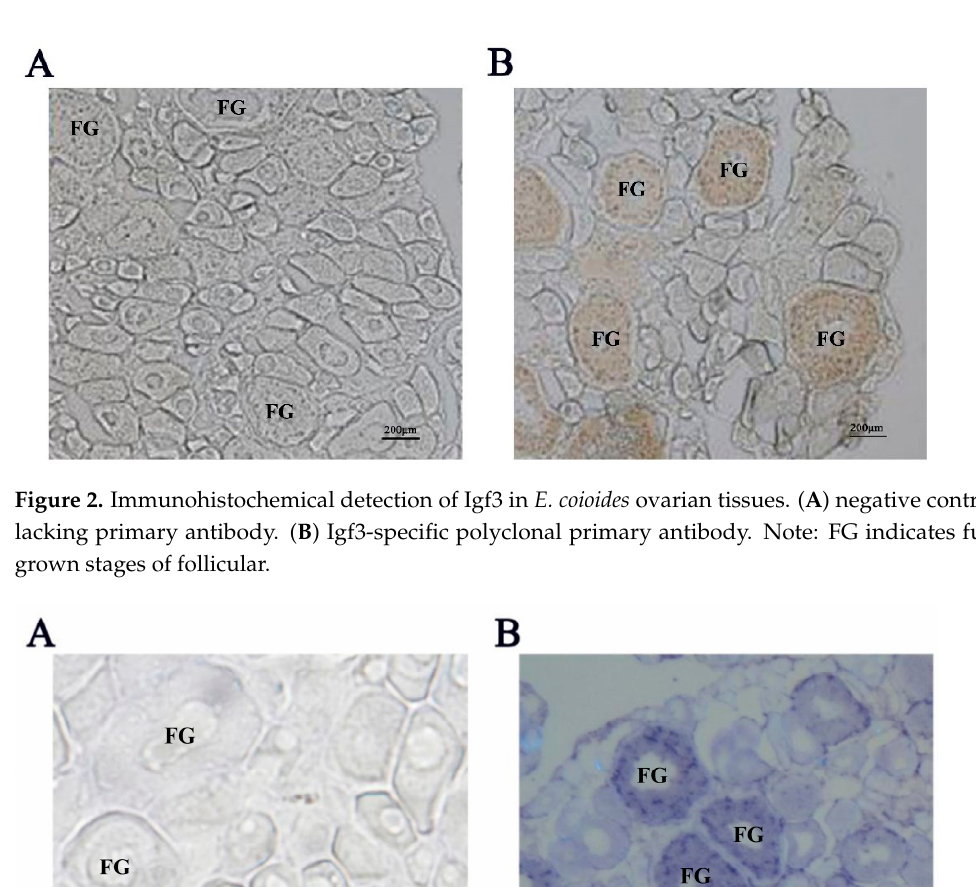
Figure 1. Western blot verification of Igf3.